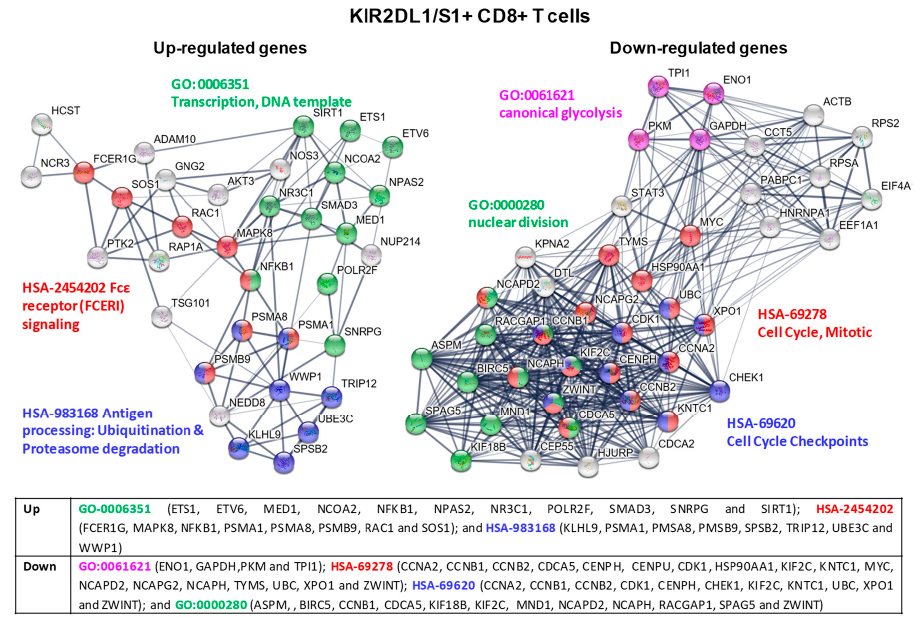
Figure 7. KIR2DL1/S1+ CD8+ T cell cluster analysis of the protein-protein interaction (PPI) network with STRING database. Hub nodes from di ff erentially expressed genes were identified using Cytoscape software and then represented using STRING to perform the functional and enrichment analysis of these pathways. The PPI network shows up-expressed genes for modules GO-0006351 Transcription, DNA template (green), HSA-2454202 Fc ε receptor (FCERI) signaling (red), HSA-983168 Antigen processing: Ubiquitination& Proteasome degradation (blue); and down-expressed genes for modules GO-0061621 canonical glycolysis (purple), HSA-69278 Cell Cycle, Mitotic (red), HSA-69620 Cell Cycle Checkpoints (blue), and GO:0000280 nuclear division (green). Briefly, the parameters used in STRING were as follows: text mining, experiments, databases, co-expression, neighborhood, gene fusion and co-occurrence were used as active interaction sources. The confidence threshold was set at 0.4. The disconnected transcripts were